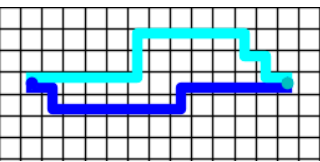
Figure 6. ( a – f ) Schematic diagrams of the start and end positions of the six cases. The position pointed to by the arrow is the end position of each robot. Three dots indicate that seven rows of grids were omitted.